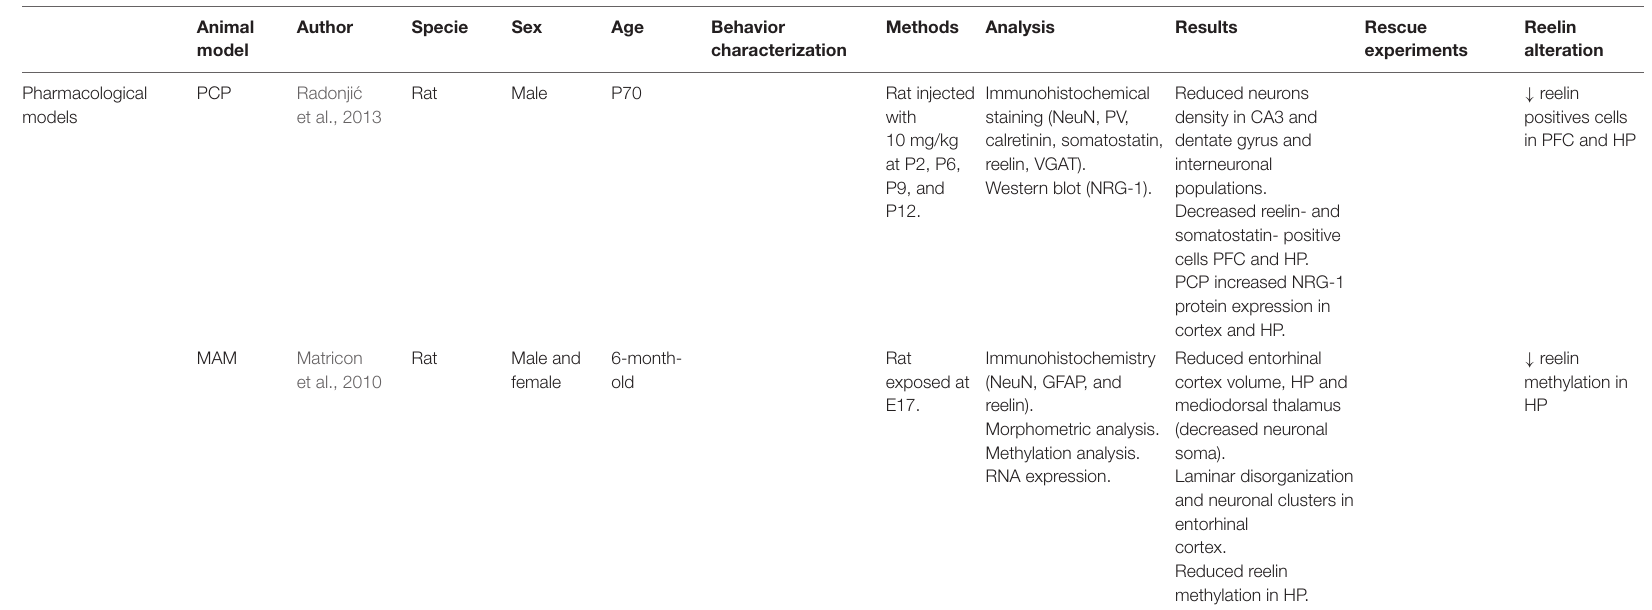
TABLE 1 | Principal findings of pharmacological model studies included in this